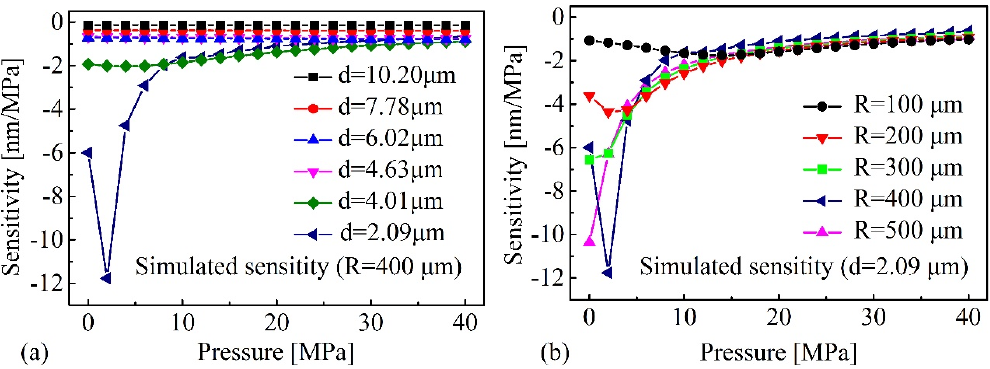
Figure 8. ( a ) Calculated pressure sensitivities of the six sensor samples S1–S6 by Model 2 with the same diaphragm curvature radius R of 400 μ m. ( b ) Calculated pressure sensitivities of S6 ( d = 2.09 μ m) with diaphragm curvature radius R ranging from 100 to 500 μ m.